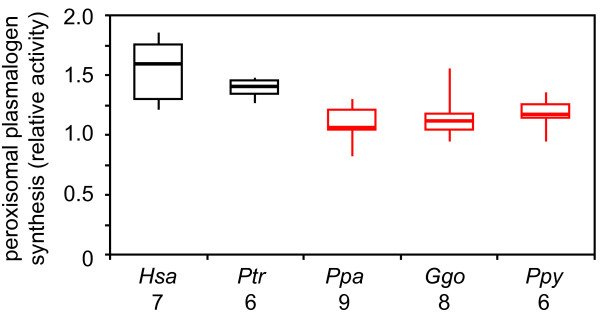
Rates of peroxisomal plasmalogen biosynthesis in human and great ape cultured fibroblasts. The relative rates of the peroxisomal relative to endoplasmic reticulum (ER) mediated steps of plasmalogen biosynthesis in cultured skin fibroblasts are provided in modified box plots. Larger ratios indicate increased activity of the peroxisomal relative to ER components of plasmalogen biosynthesis. The number of cultures analyzed is provided on the X-axes. Animal cohort data are color-coded as indicated in Figure 4.